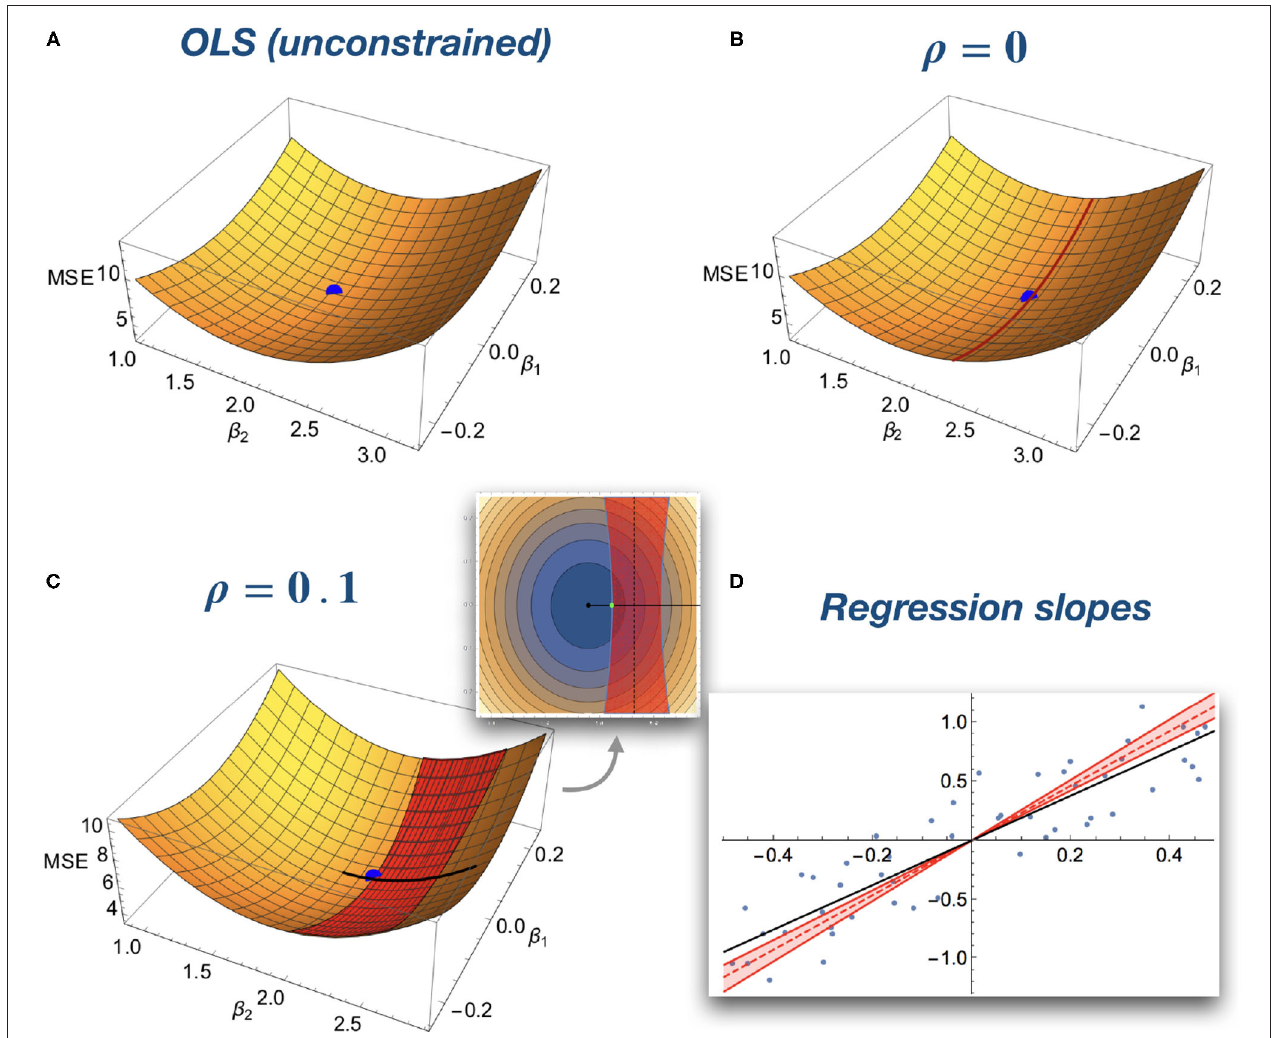
FIGURE 2 | Geometrical intuition of optimization of an OLS model with correlation constraints. For illustrative purposes, simulated data is used with a model with two regression coefficients and without intercept. (A) x and y axes represents different combinations of regression coefficients, whereas the z-axis represents the residual sum of squares. The standard unconstrained OLS fit corresponds to the minimum of the quadratic surface (blue ball). (B) Zero correlation constraint. The solution space is restricted to a hyperplane (red line on the surface). The blue dot represents the optimal constrained solution. (C) Bounded correlation. The solution space is restricted to the space between two paraboloids (red band on the surface). The inset depicts a “top down” view on the surface. (D) Corresponding regression slopes. The OLS solution is depicted as a black line. The correlation bound allows for a set of solutions (red shaded area) limited by ρ = − 0.1 and ρ = 0.1 (red solid lines). The zero ADC solution is depicted as a red dashed line. All constrained solutions have a larger slope than the OLS